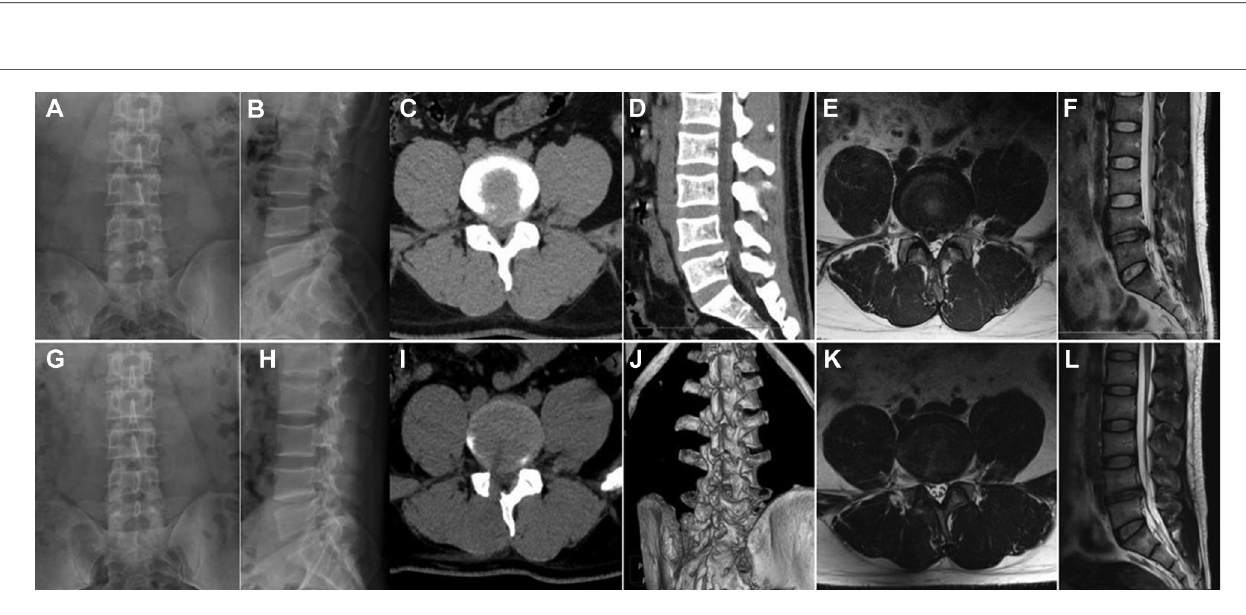
FIGURE 2 Pre- and postoperative x-ray, CT and MRI of UBE. ( A,B ) Preoperative x-ray. ( C – F ) Preoperative CT and MRI showing disc herniation. ( G,H ) Postoperative x-ray. ( H,I ) Postoperative CT and MRI showing the extruded disc was